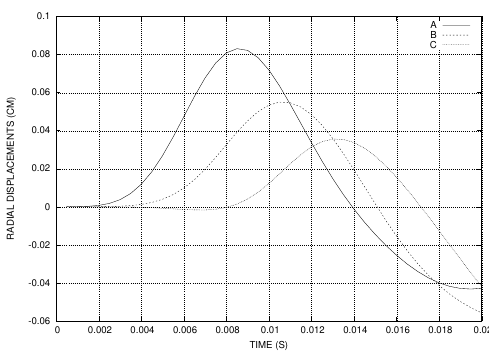
Figure 9. The time history of the displacement of three points on the interface using sin-like stress at the inlet (Mesh 1).